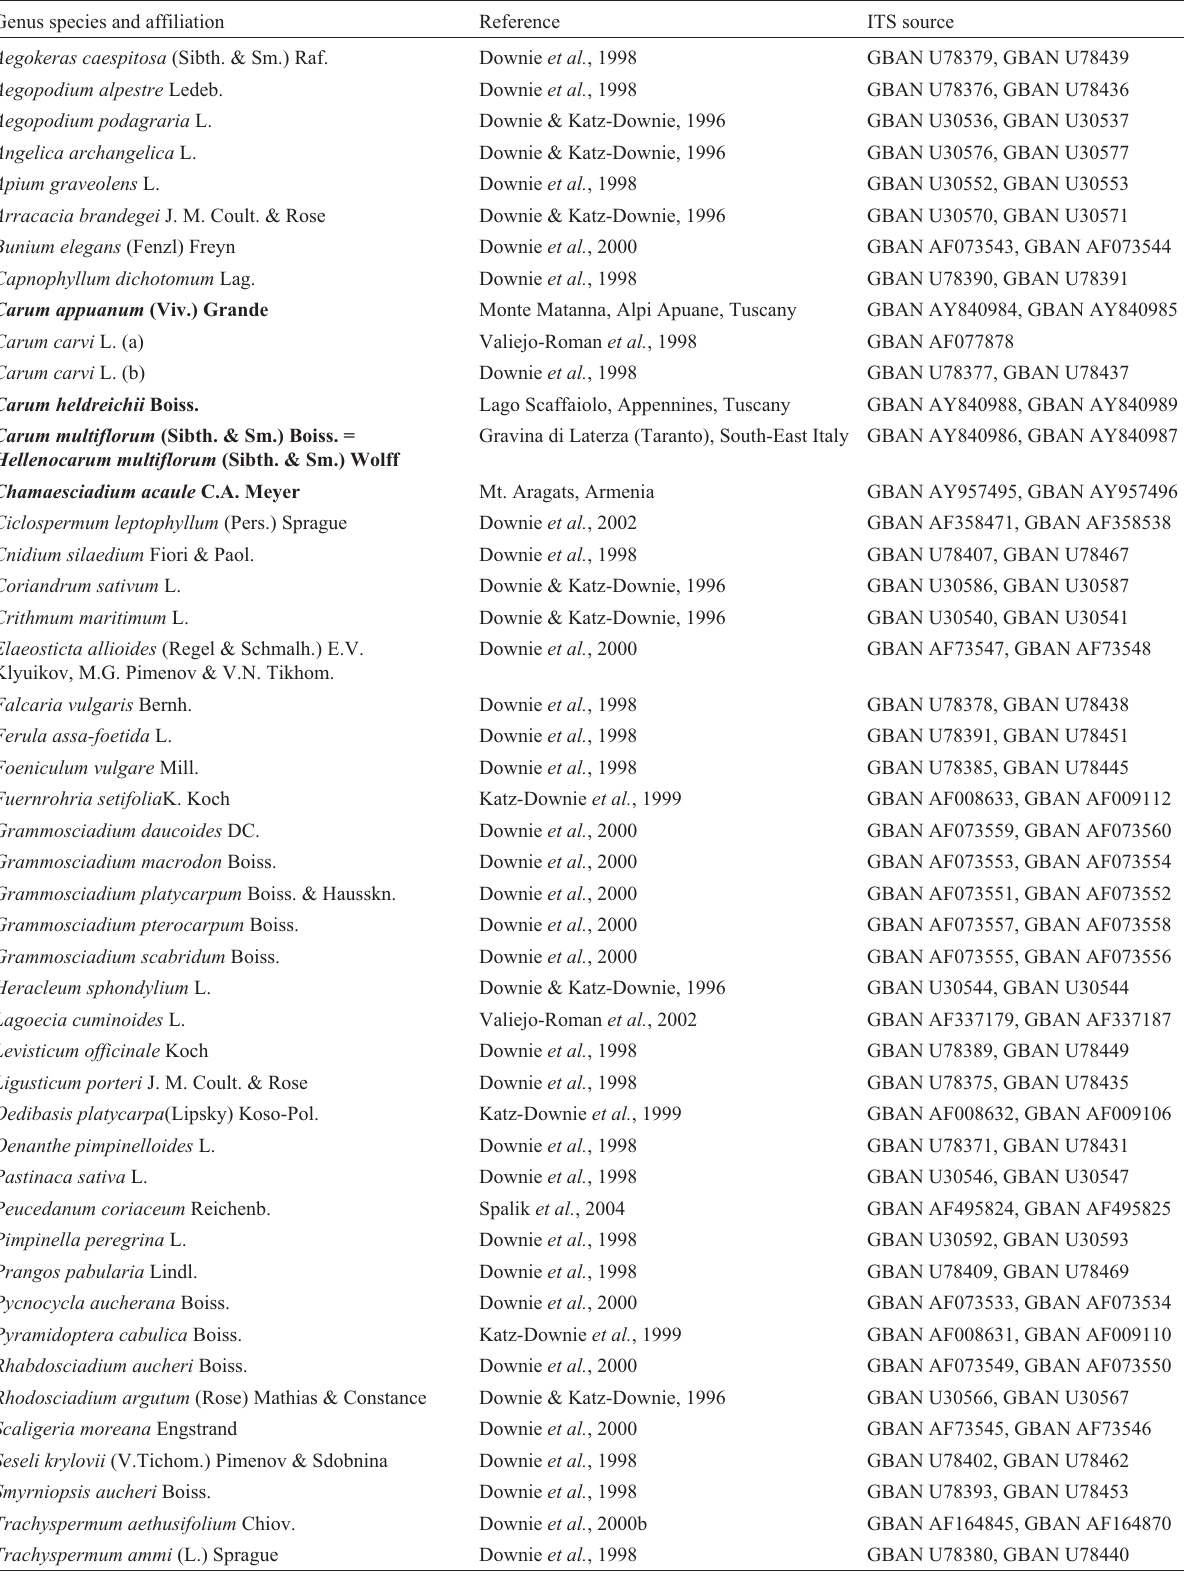
Table 1 - Apiaceae accessions used in our internal transcribed spacer (ITS) sequence study. When a single GenBank (GBAN) accession number is indicated, the whole ITS1-5.8S-ITS2 is intended, otherwise the first accession correspond to ITS1 and the second to ITS2. Species sequenced by the authors are underlined. Herbarium samples are available from the